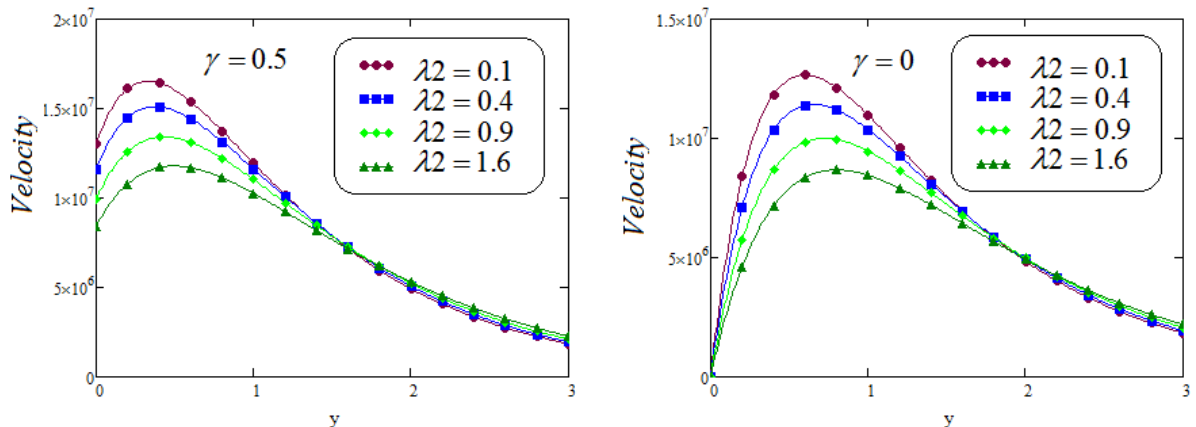
Figure 12. Velocity field under slip conditions as well as the velocity field under no-slip conditions for different λ 2 values when f ( t ) = sint , t = 1.5, Gr = 3.5, λ 1 = 0.6, Pr = 0.71, M =